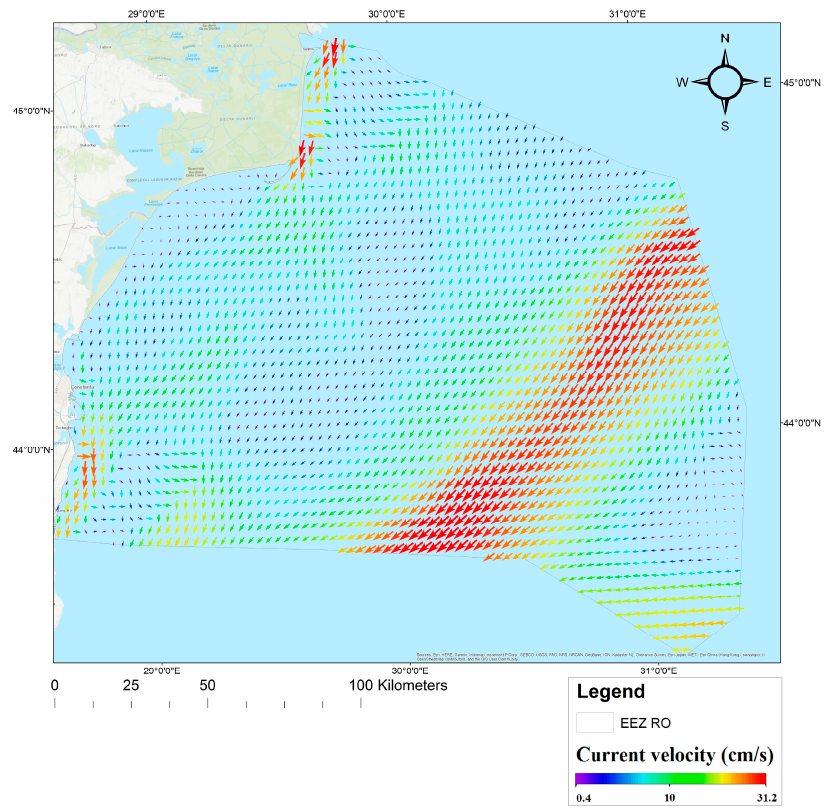
Figure 6. Multiannual mean distribution of surface currents on the Romanian coast (data source http://www.marine-research-journal.org/index.php/cmrm/article/view/200/165 (accessed on 17 January 2023)) .